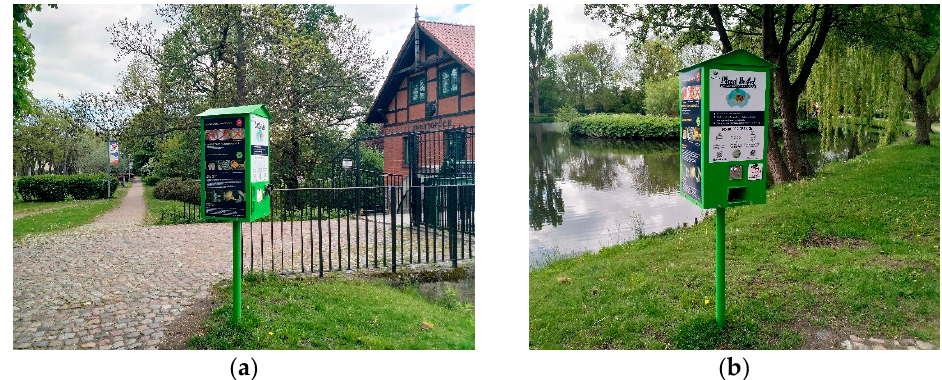
Figure 10. Educational gardens in the summer of 2021 ( a , b ), source: author.